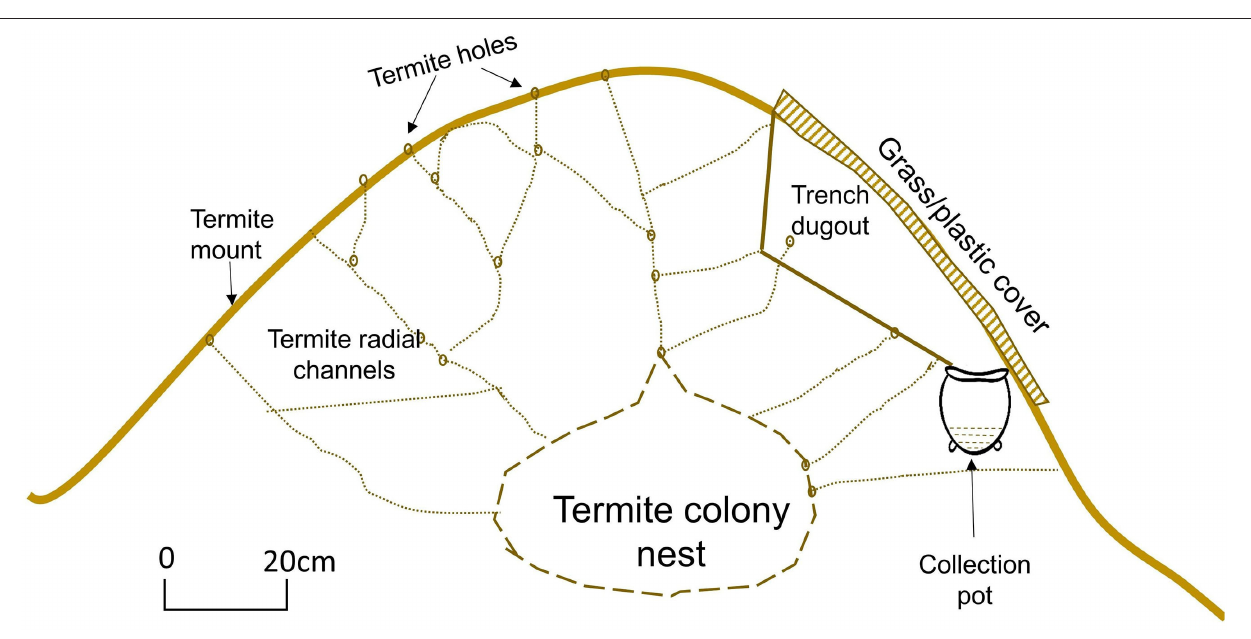
FIGURE 3 | Traditional trap used to selectively harvest the alate flying termites during the rainy